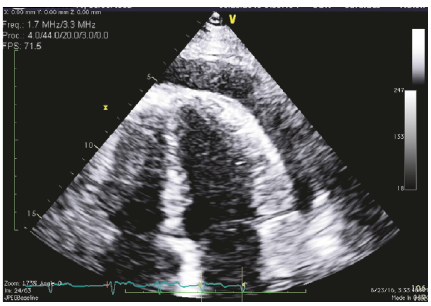
Figure 1: Two-dimensional transthoracic echocardiogram showing a large pericardial effusion in the apical view.